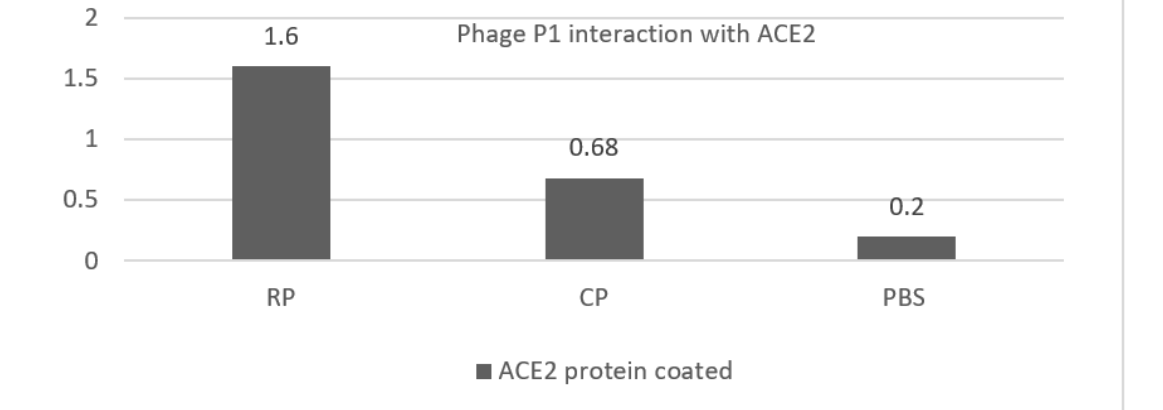
Figure 5. Interaction of P1 protein, displayed on bacteriophage pVIII, with ACE2 protein coated in ELISA wells. CP and PBS are negative control samples. The mean OD in the negative control wells was 0.44, with a standard deviation of ±0.27. An optical density >1.2 was considered positive (mean of negative control + 3*SD). Y -axis indicates the optical density. Abbreviations: RP: P1 recombinant phage, CP: control phage, PBS: phosphate buffer saline, ACE2: angiotensin-converting enzyme 2.